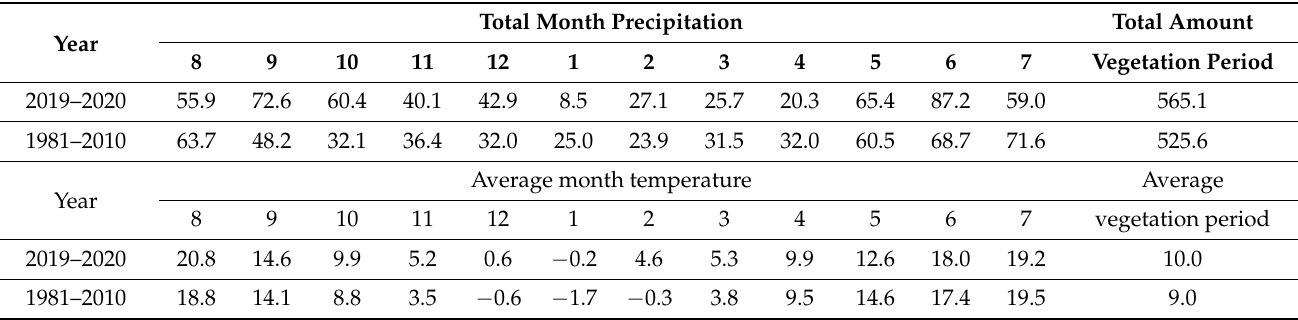
the Cruiser OSD mordant at 15 l/t, sowing rate was 3.5 kg/ha, and distance between the